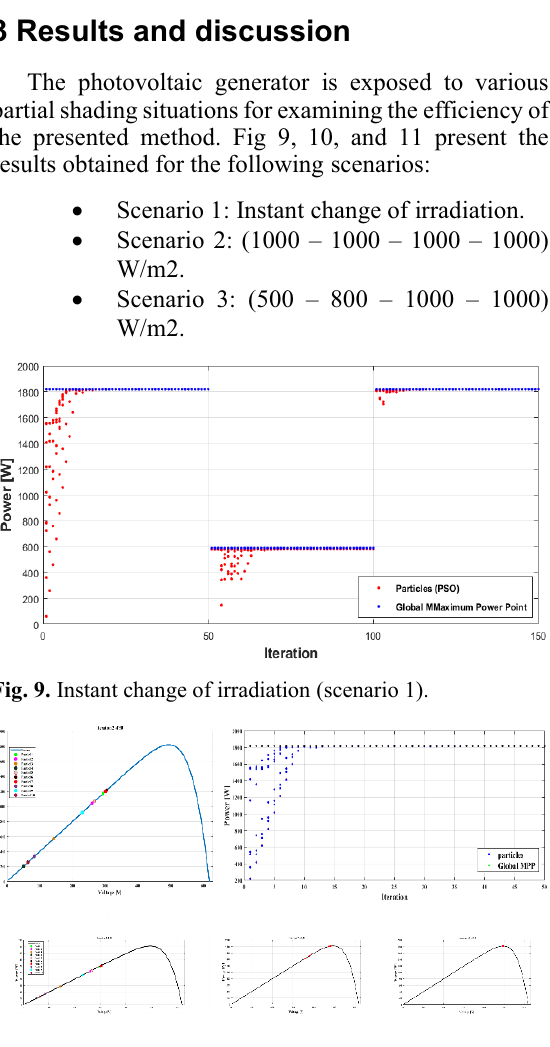
Fig. 10. Results obtained for scenario 2 (a, b, and c: Position of swarm particles, d: History of particle positions)